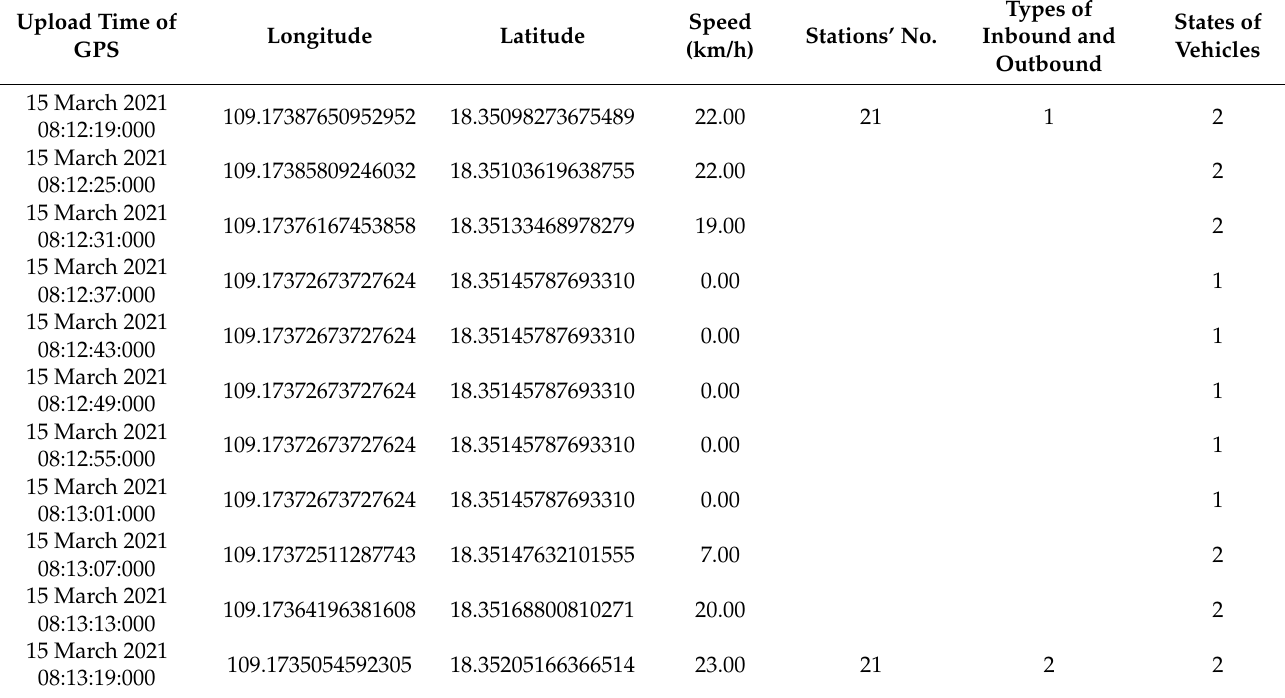
Table 4. Buses’ operational states in Sanya.